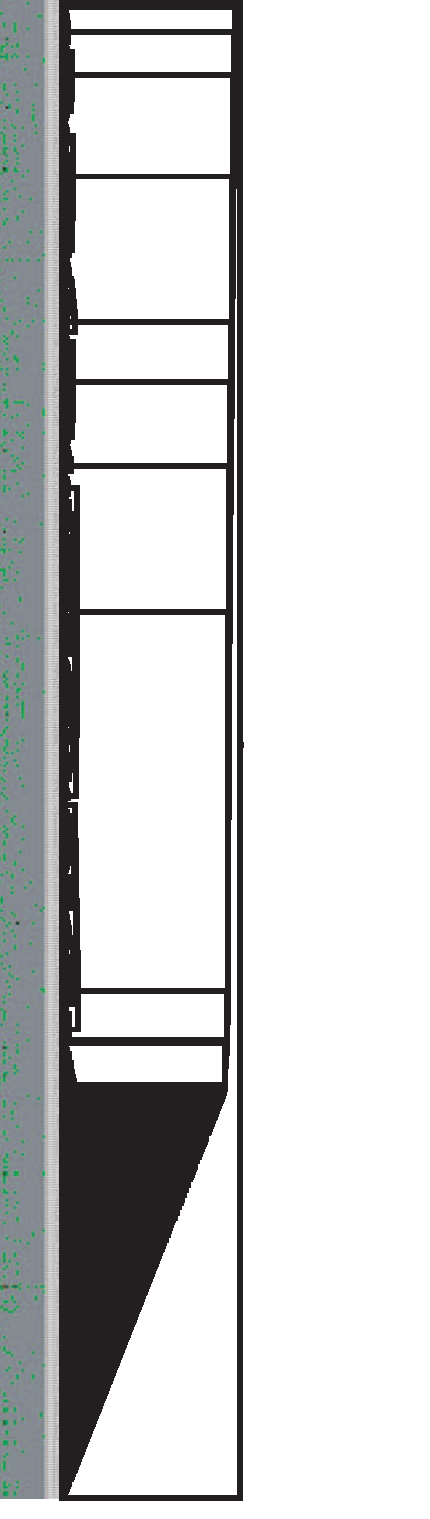
Figure 3. Representative annotation matrices for molecular function. Grey cells in the matrix are not within the outlier of each category. The left part of the tree are generated from GO DAGs not based on the similarities of the rows of the matrix.